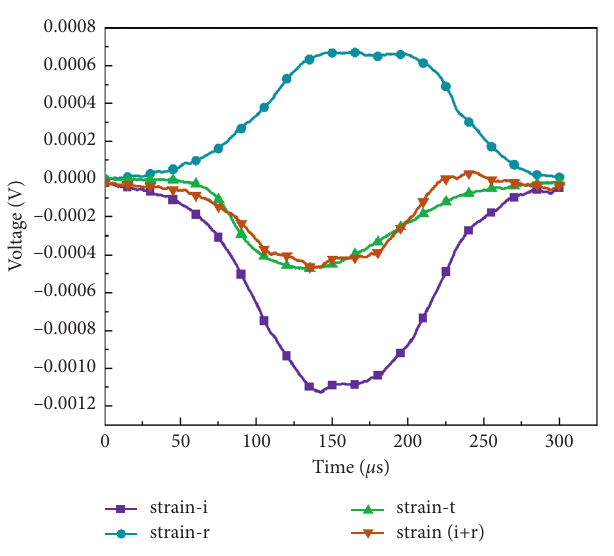
Figure 3: Dynamic stress balance